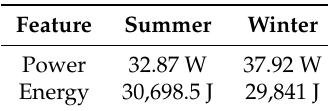
Table 4. Available power from household water